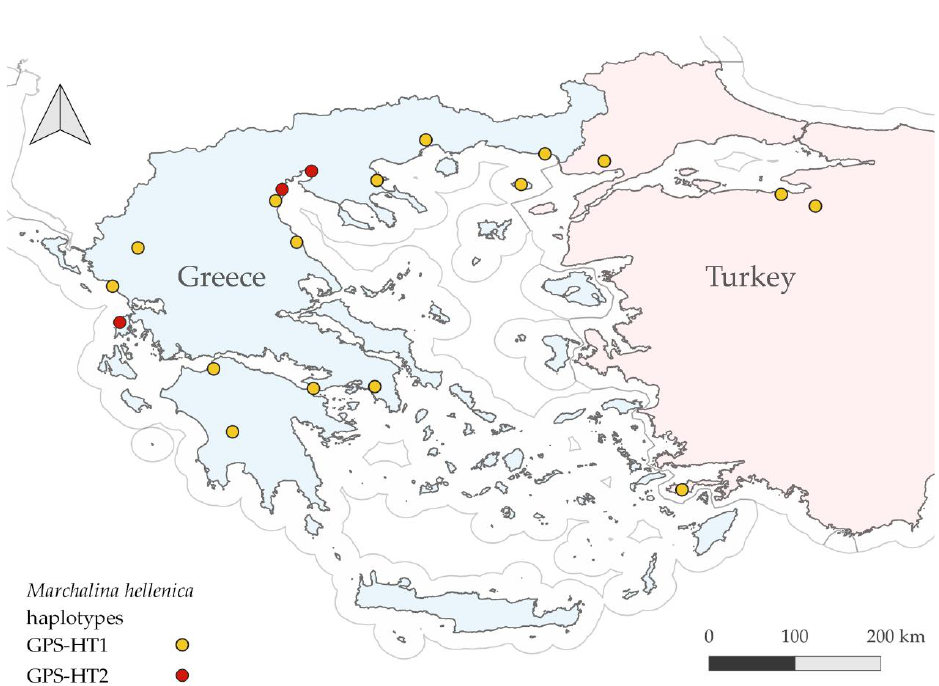
Figure 1. Haplotypes revealed by the mtDNA analysis in Greece (this study) and Turkey [37]. Hap- lotype 1 (GPS-HT1, yellow points) dominates Greece and four sites in Turkey, while haplotype 2 (GPS-HT2, red points) is exhibited only in three sites in Greece (Thessaloniki, Makriyalos, and Lefkada).